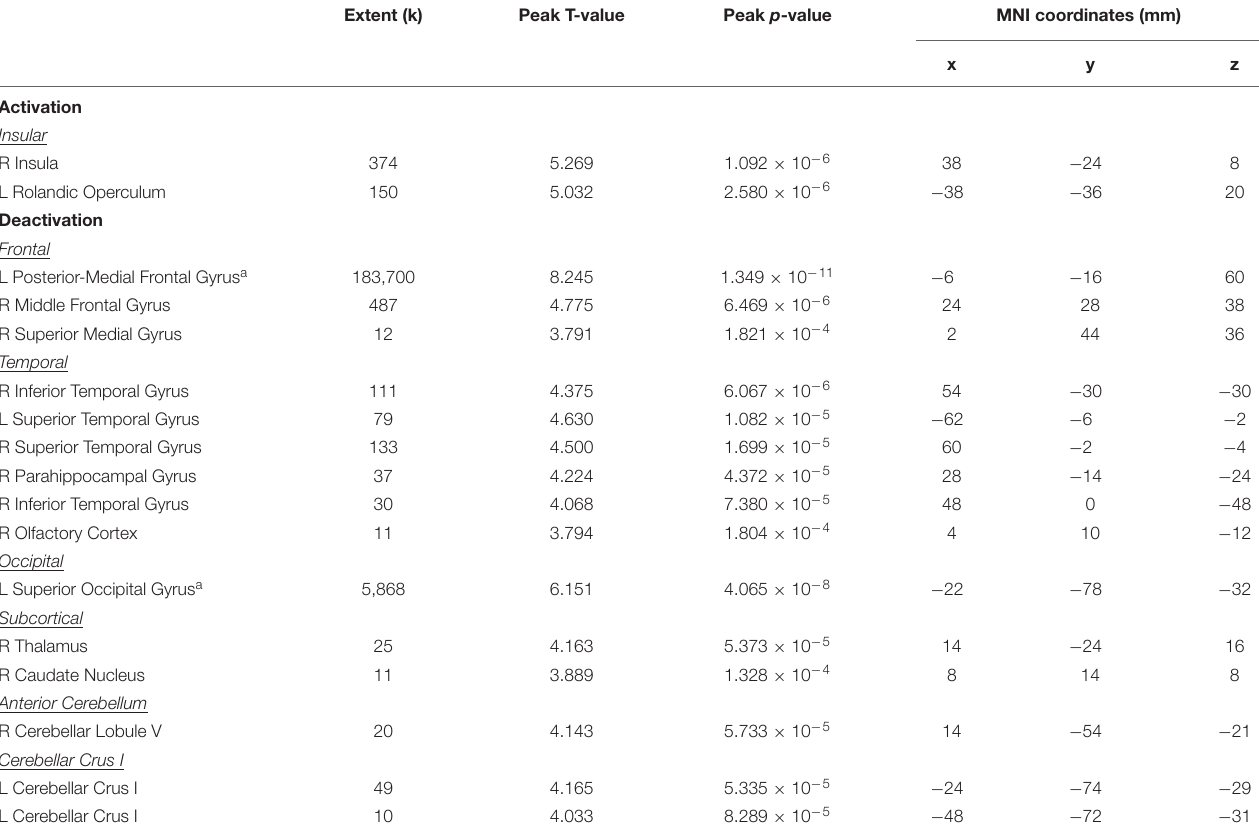
TABLE 1 | Regions of activation or deactivation in response to vestibular stimulation. Extent